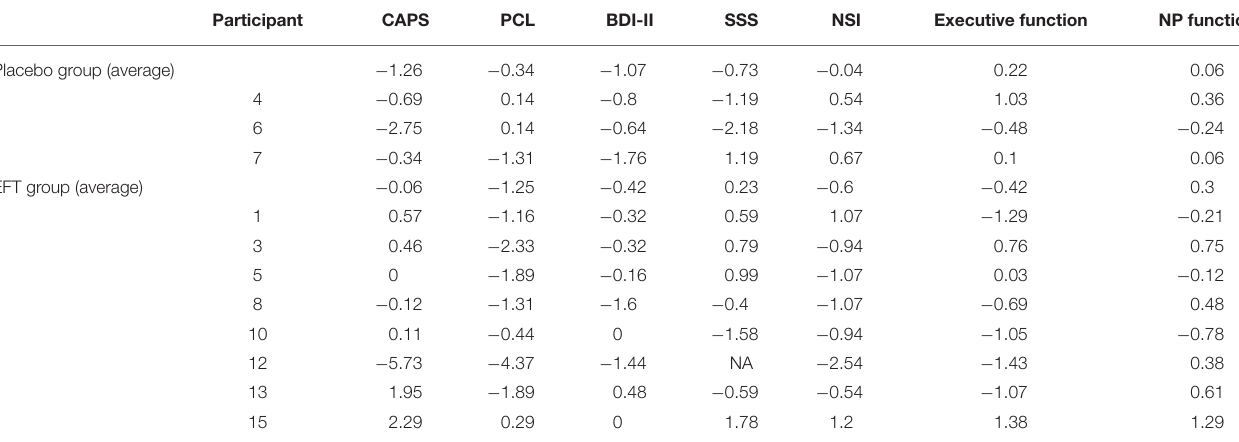
TABLE 3 | Changes in psychological and neuropsychological scores from pre- to post-treatment. Participant CAPS PCL SSS NSI Executive function NP